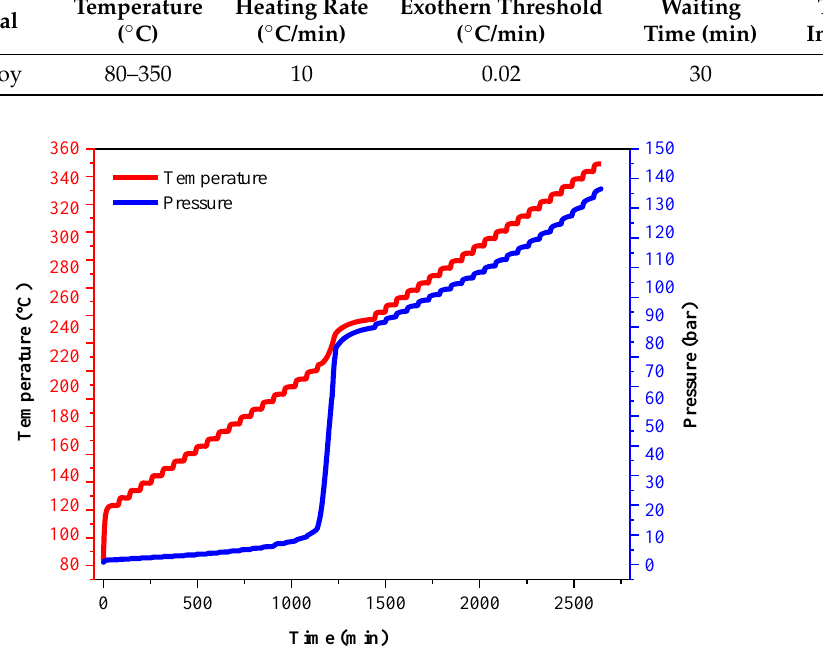
Figure 4. Temperature and pressure versus time (0–2700 min) curves of LP30 + PFPN.